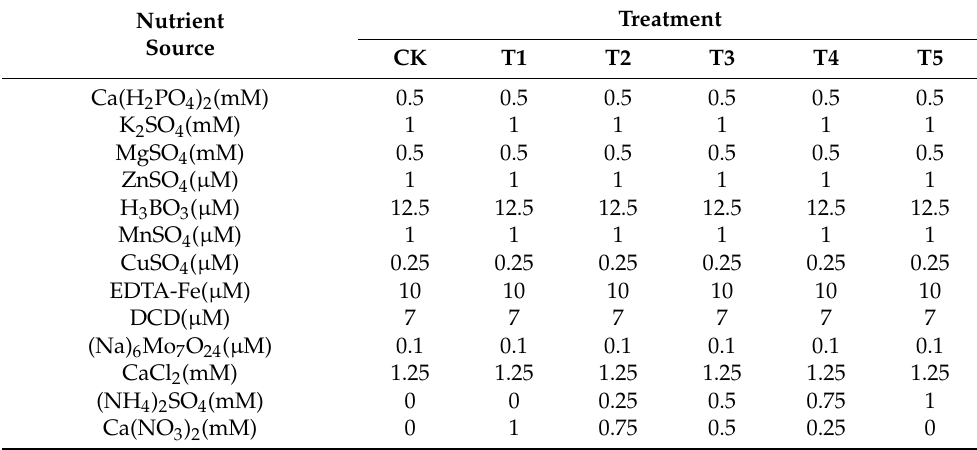
Table 1. Composition of the nutrient solution under different NH 4+ :NO 3 − ratio treatments. Nutrient Source